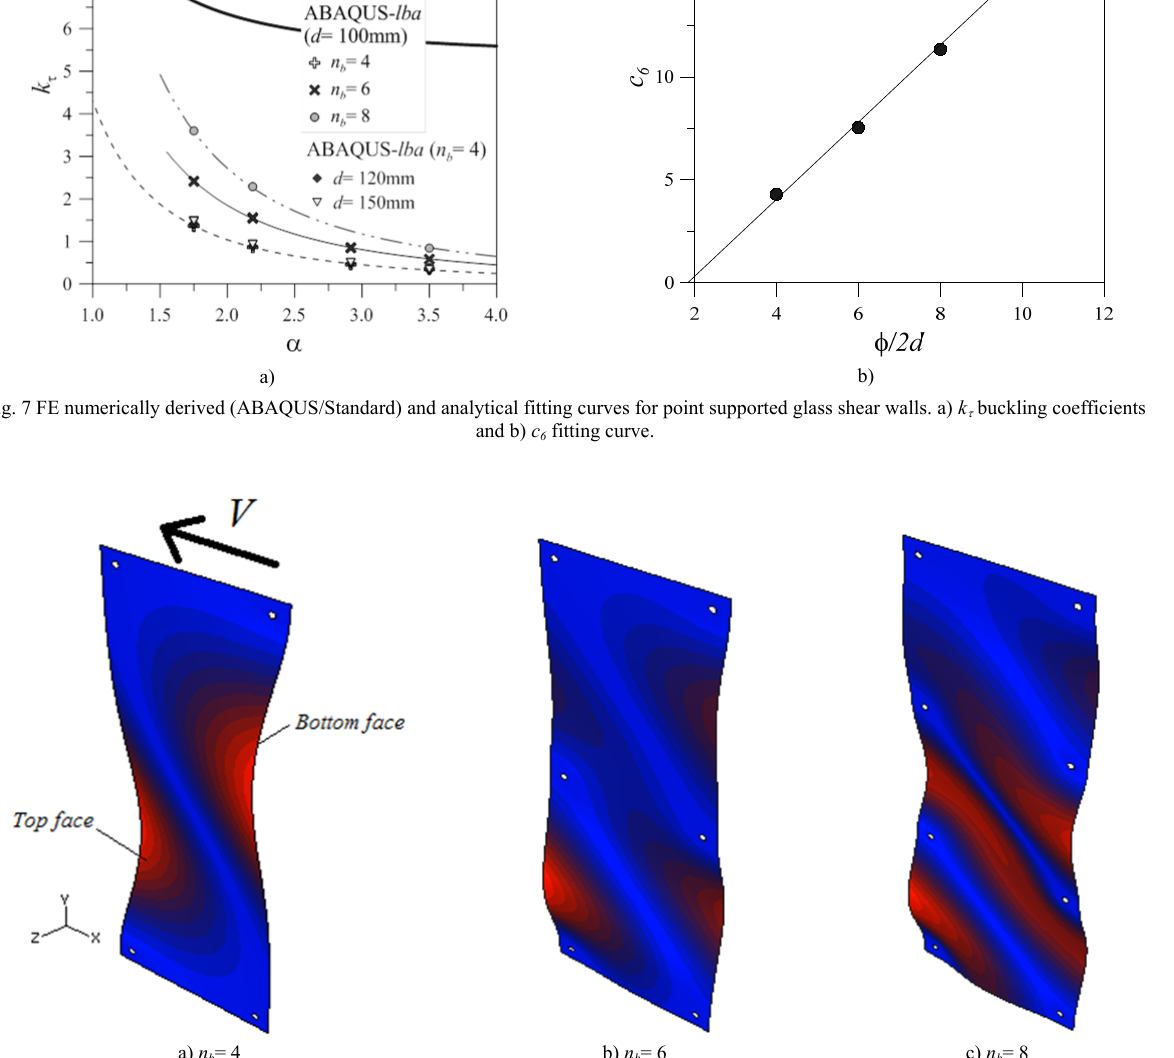
Fig. 8 FE fundamental buckling shapes for glass shear walls with mechanical point connectors